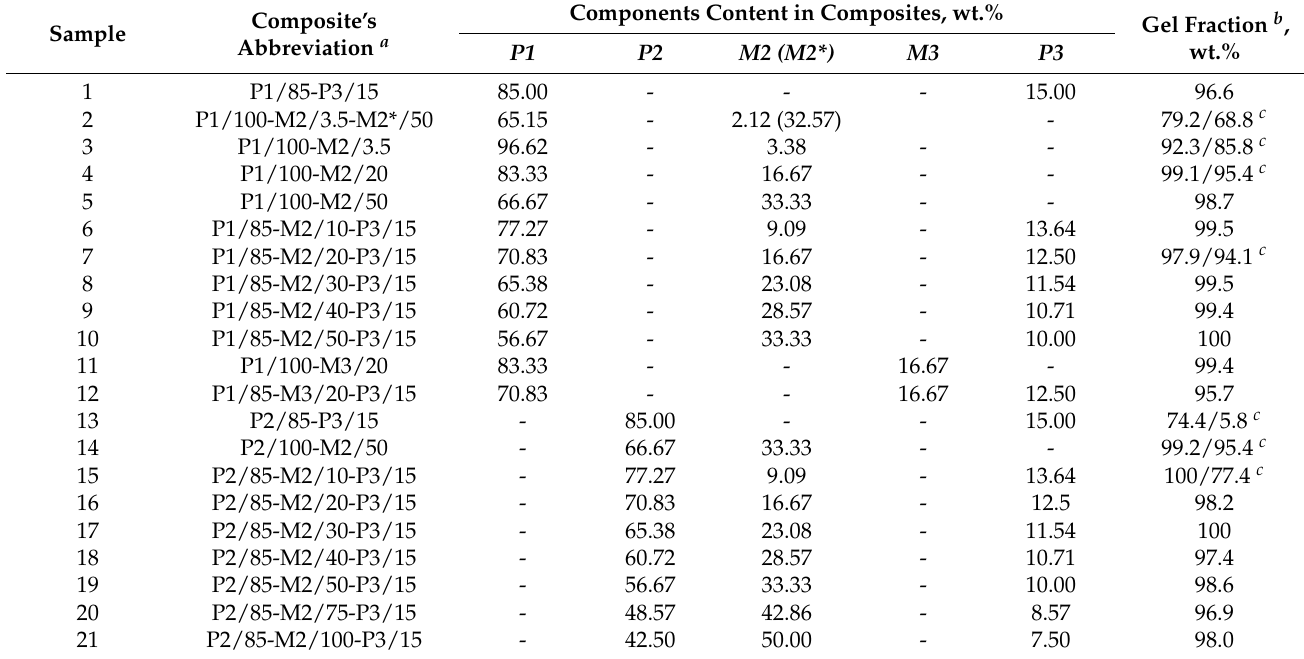
Table 1. Compositions of molecular composites